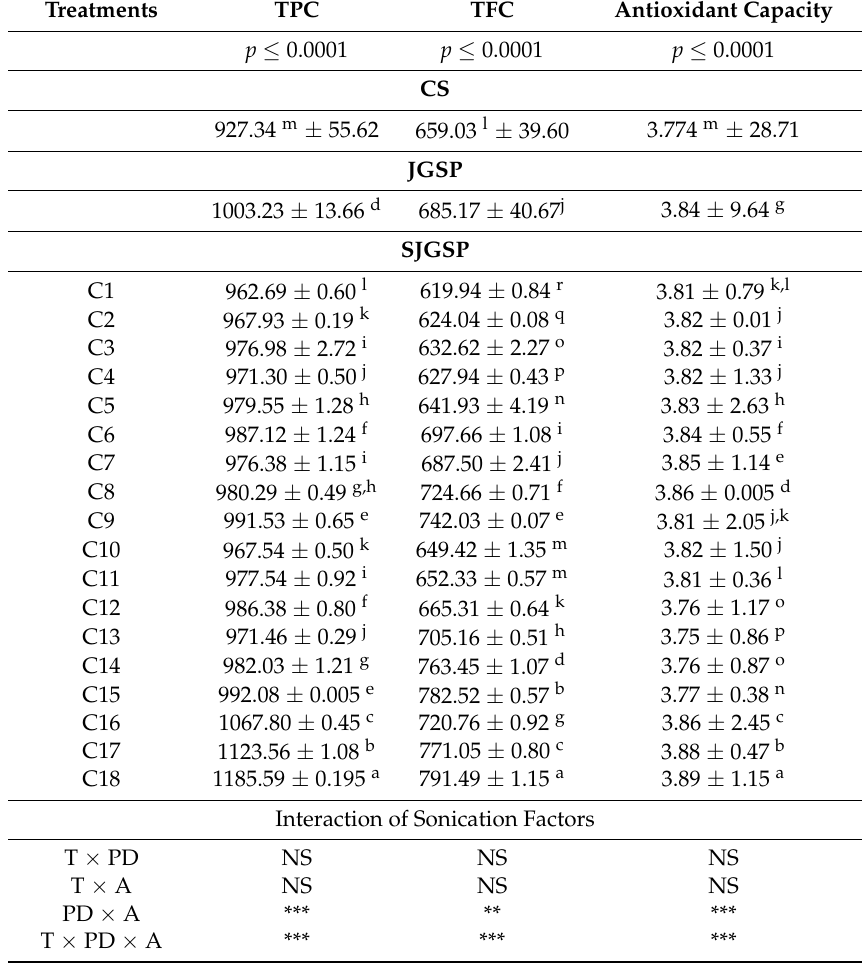
Table 1. The content of total phenols (mg GAE L − 1 ), flavonoids (mg GAE L − 1 ), and antioxidant capacity (mmol TE L − 1 ) of the juice